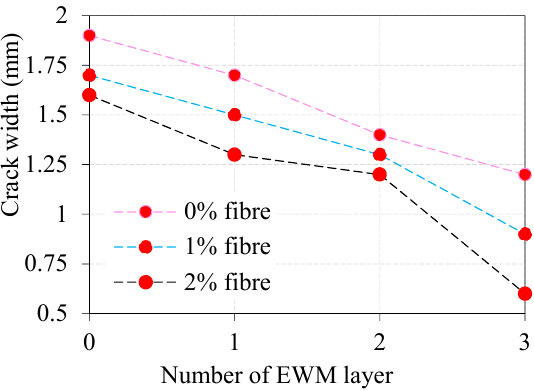
Figure 8. Comparison of crack width of ferrocement panels with various fiber dosage and EWM layers.